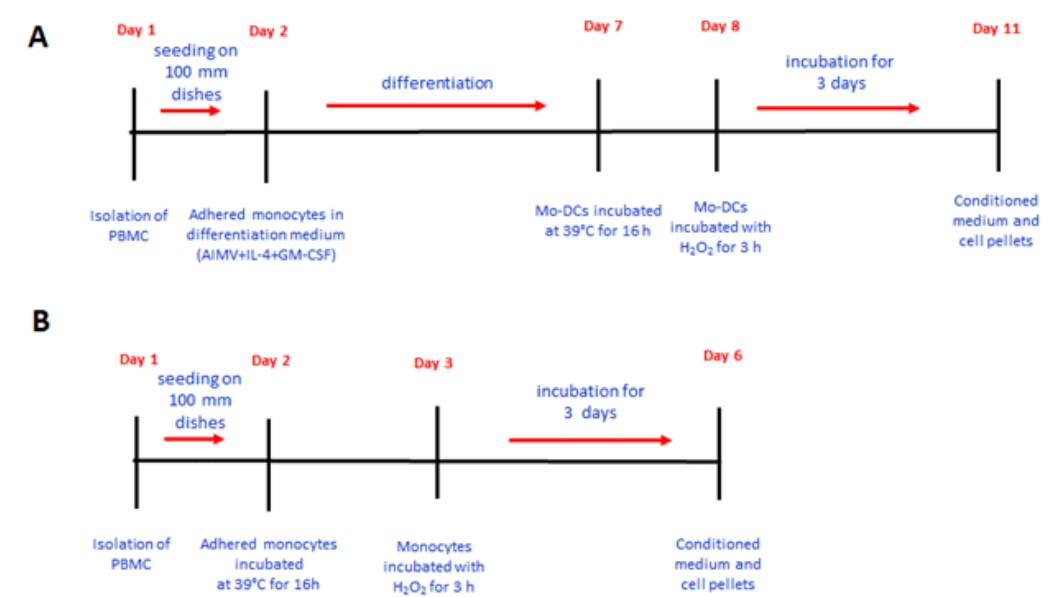
Figure 2. Flow diagram of the experiment. ( A ) Mo-DCs were obtained upon incubation of monocytes with serum-free medium (AIMV) in the presence of IL-4 and GM-CSF starting on Day 2. On Day 7, Mo-DCs were incubated at 39 ◦ C for 16 h, while other dishes were incubated with H 2 O 2 for 3 h on Day 8. An incubation of 3 days started for all dishes on Day 8 and ended on Day 11. ( B ) The same protocol was used for monocytes, except that they were exposed to hyperthermia on the day after they were plated (Day 2) or incubated with H 2 O 2 on Day 3. The incubation of all dishes at 37 ◦ C started on Day 3 and finished on Day 6.